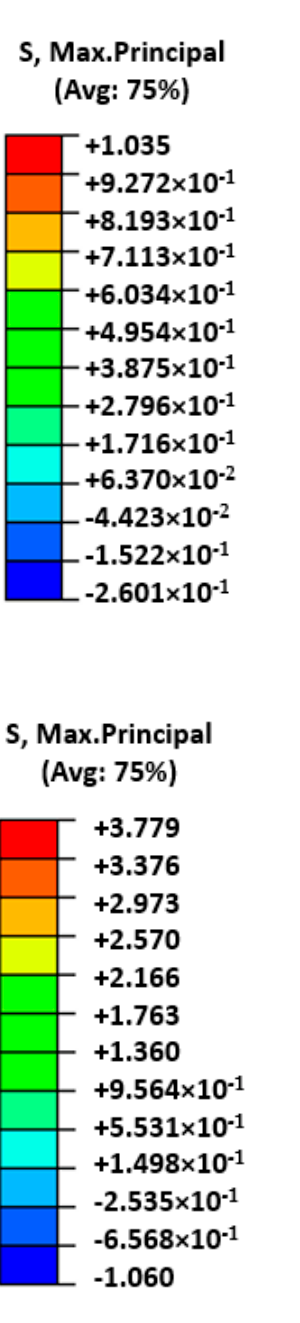
Figure 8. Stress distribution in mortar.